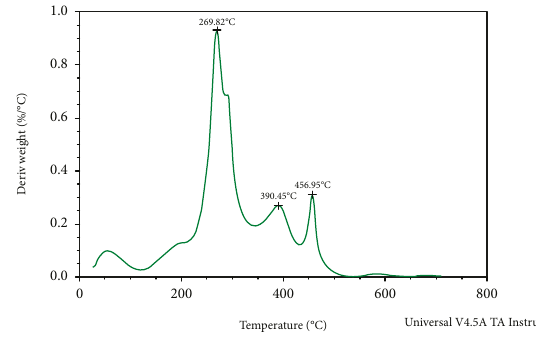
Figure 11: DTGA curve of the date pit powder.